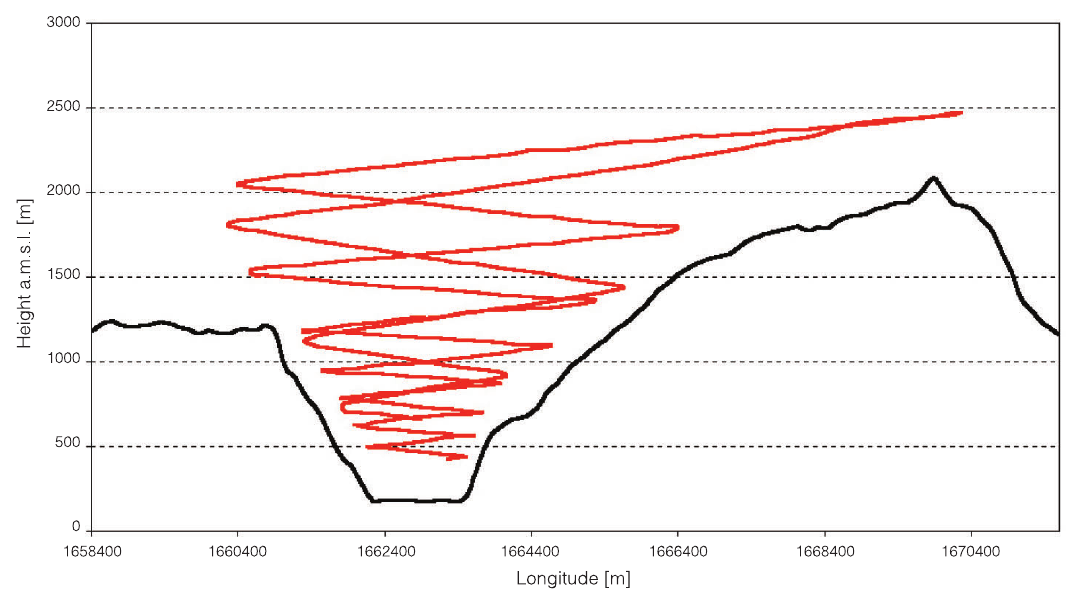
Fig. 6. Vertical projection of the fl ight trajectoriy over